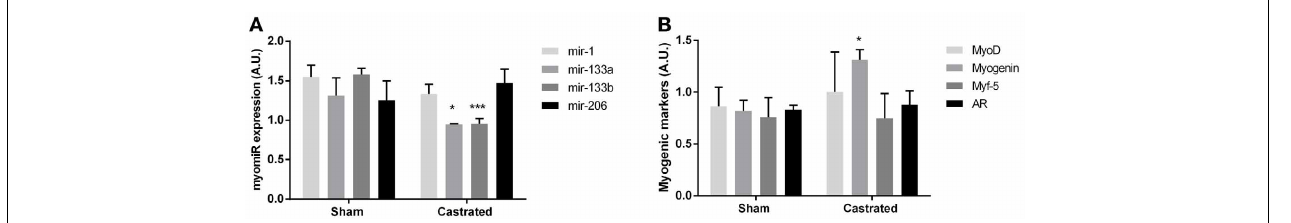
FIGURE 4 | Muscle of castrated ( n = 5) and sham operated ( n = 4) C57BL/6J mice. An unpaired t-test demonstrated a significant lower expression of mir-133a ( ∗ P < 0 . 05) and mir-133b ( ∗∗∗ P < 0 . 001) in the skeletal muscle of castrated mice. The expression of mir-1 and